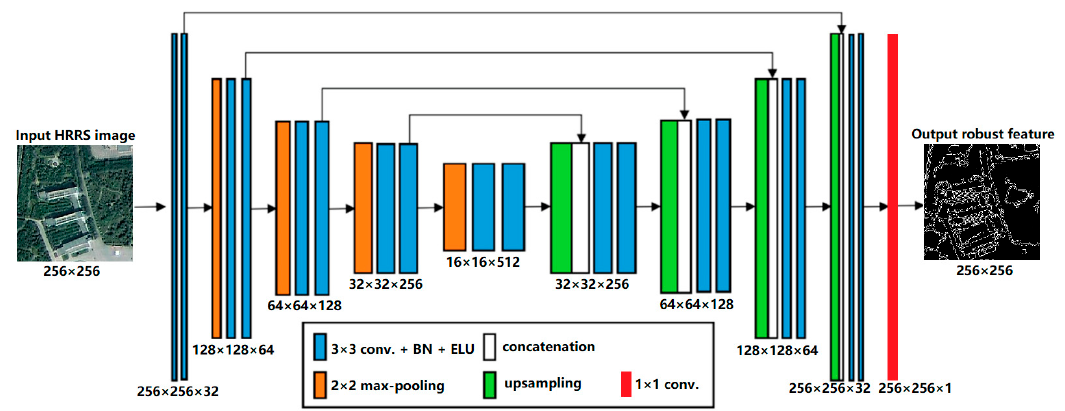
Figure 5. Architecture of the modified U-net network.